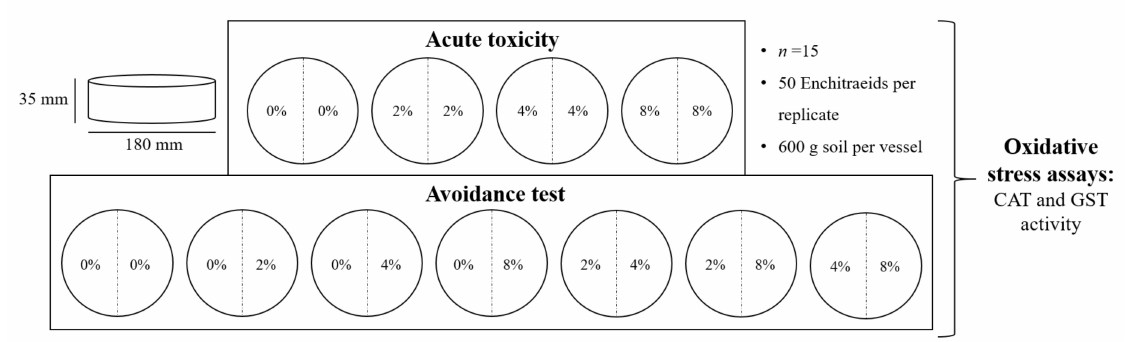
Figure 1. A schematic representation of the experimental setup. CAT: catalase; GST: glutathione